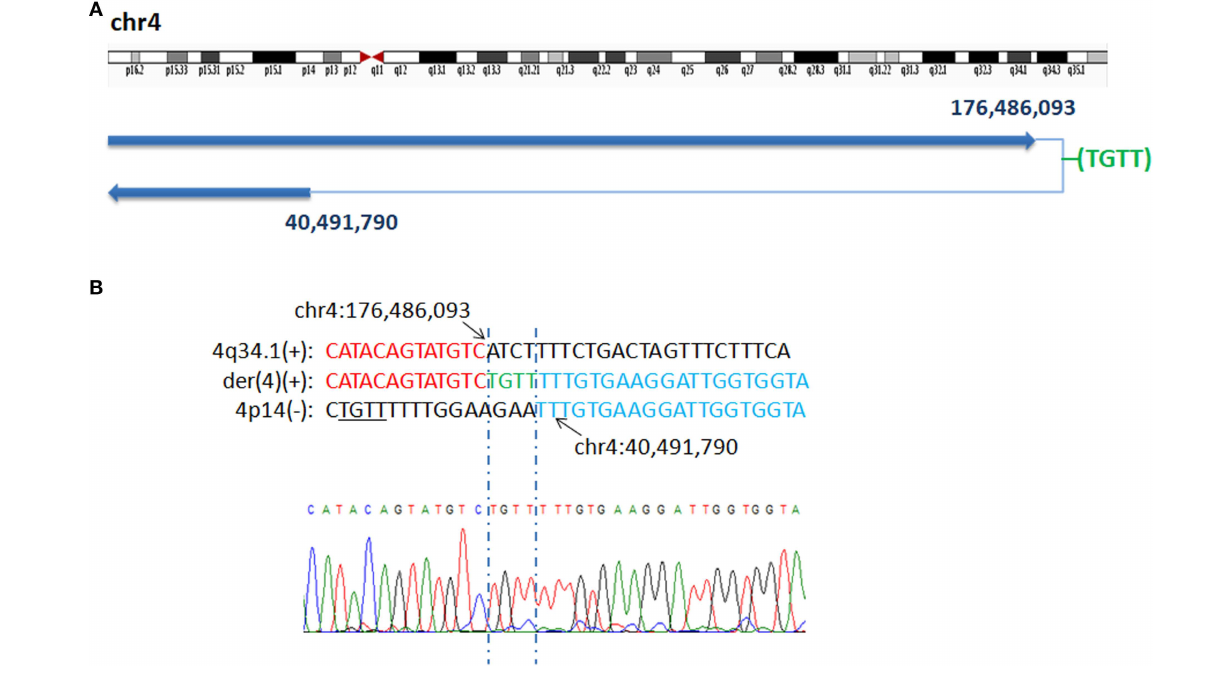
FIGURE 2 | Breakpoints analysis and validation in P5. (A) Sanger sequencing of the junction fragments confirmed that the breakpoints on chromosome 4 were located at chr4q34.2: 176,486,093 and chr4p14: 40,491,790. (B) The breakpoints mapped at the base-pair level by Sanger sequencing. Rearrangement junction sequences (middle line) and matching reference sequences (top and bottom lines) are shown with different colors depending on the involved chromosome region (4q34.1-red, 4p14-blue). The breakpoint site is indicated in blue line. Der4( + ) indicates the junction sequences near the centromere. Green letter, insertion. Sequence with black underline indicate the potential origin of the insertion at